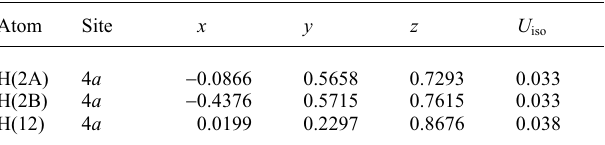
Table 2. Atomic coordinates and displacement parameters (in Å 2 ) .